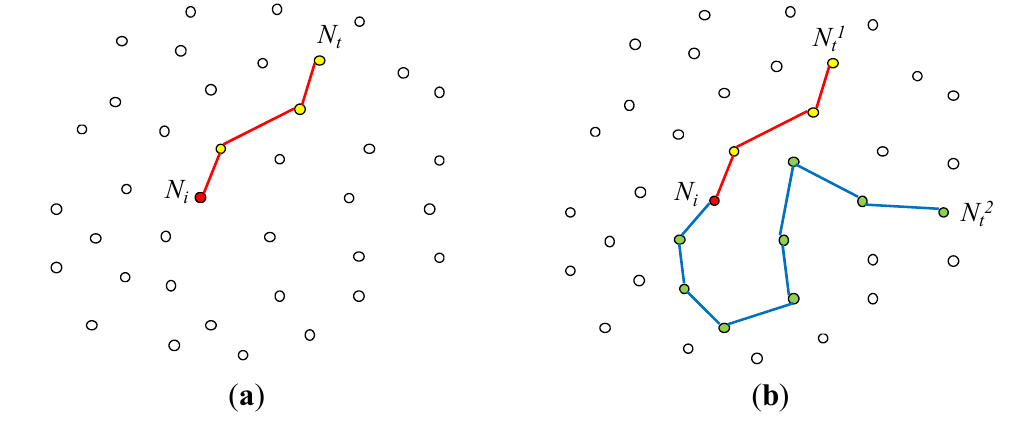
and its target node N . A join between N i t 1 and N 2 for one initiator node N t t